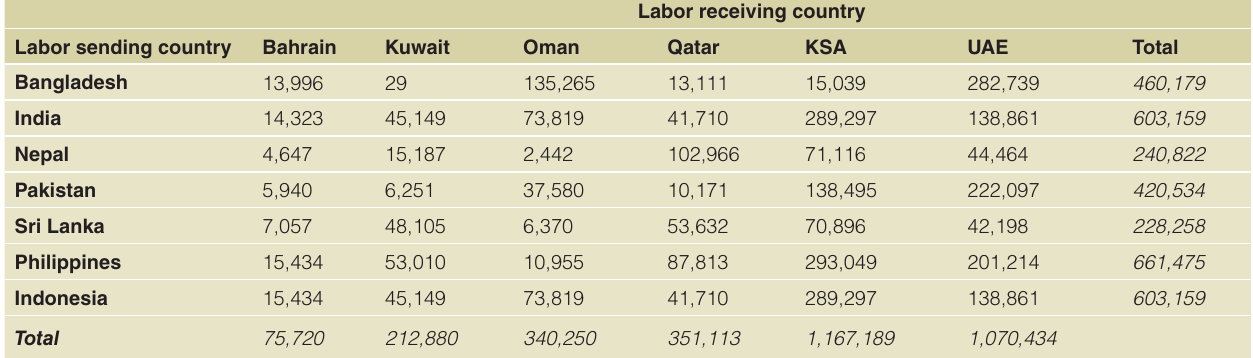
Table 2. Outflow of workers from selected Asian countries to the Gulf Cooperation council countries in 2010 26